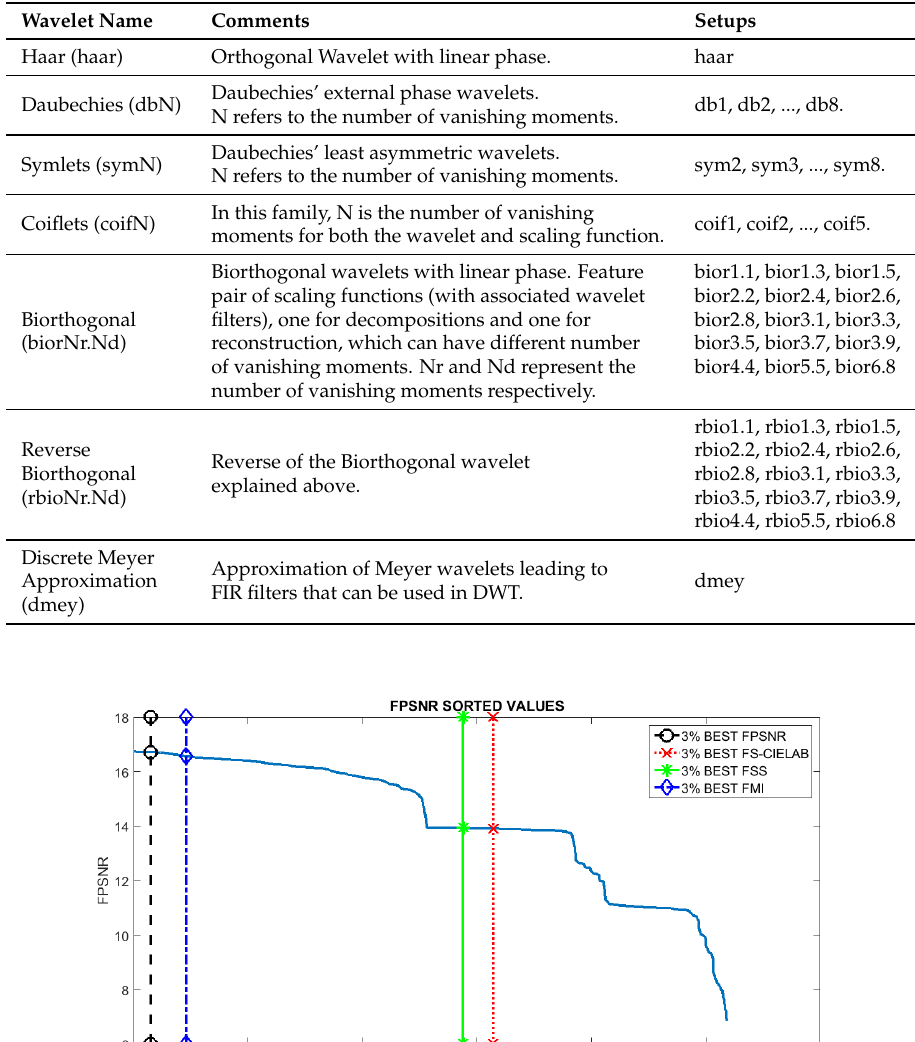
Table 2. Wavelet families evaluated in the current